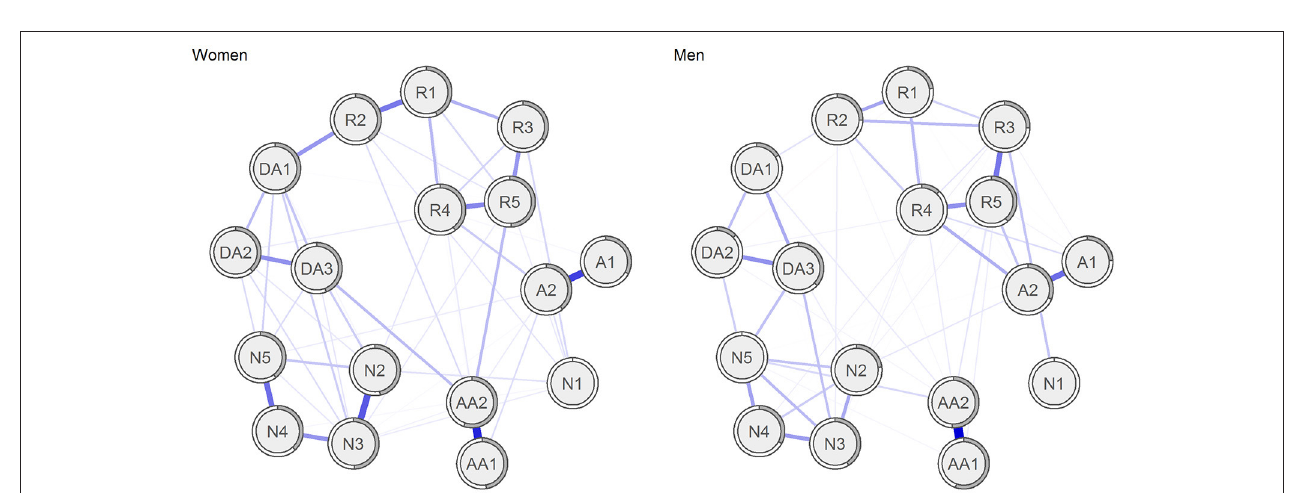
FIGURE 2 | Networks of the symptoms of posttraumatic stress in women and men with sum of PCL ≥ 30.